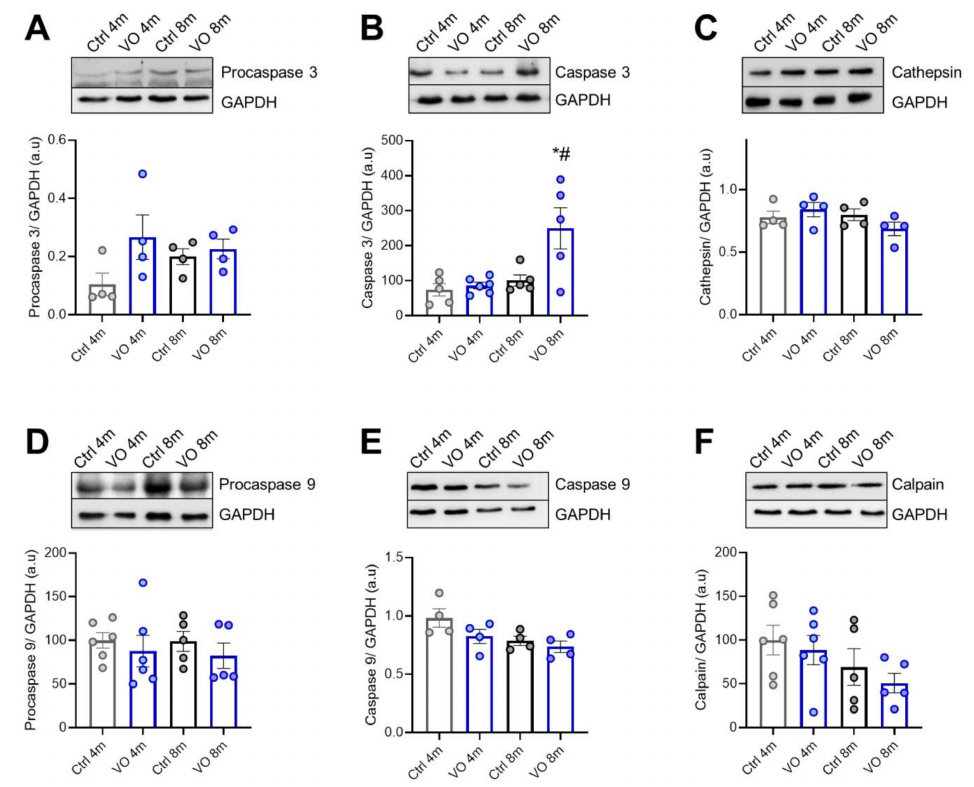
Figure 4. Proteases of the protein quality control system. ( A ) Procaspase 3 expression level from left ventricle tissue. ( B ) Active caspase 3 level, ( C ) cathepsin levels, ( D ) procaspase 9 expression level, ( E ) active caspase 9 level, ( F ) calpain levels. Data are shown as mean ± SEM; n = 4–6. * p < 0.05 4-months vs. 8-months, # p < 0.05 Ctrl vs. VO using one-way ANOVA Tukey multiple compar- isons